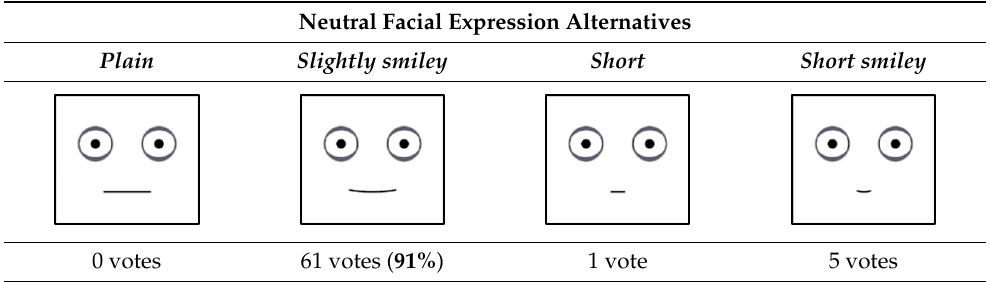
Table 6. Alternatives considered to represent a neutral facial expression and votes received.